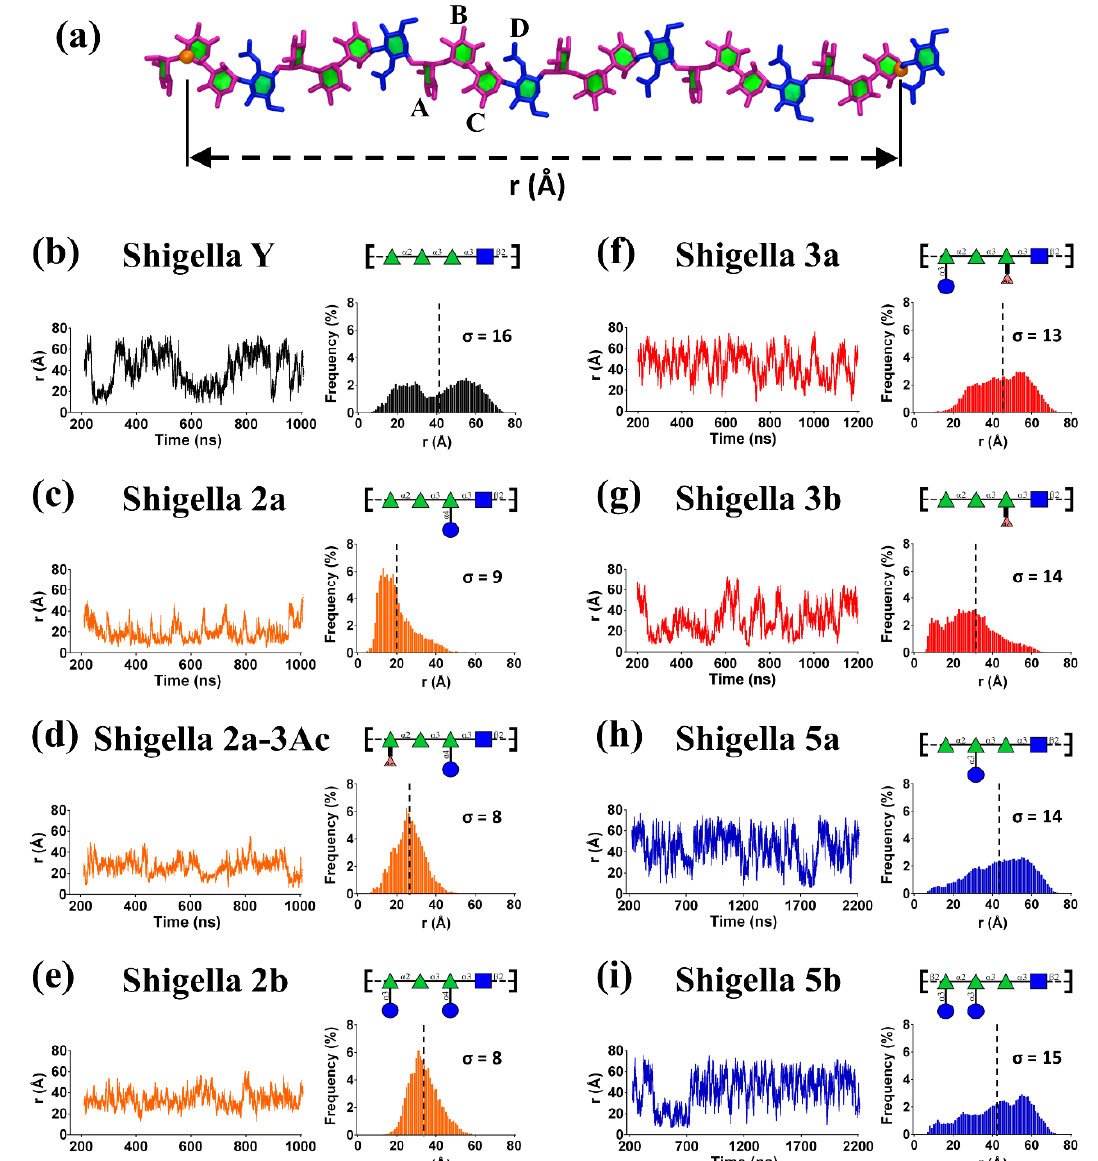
Figure 2. Comparison of the r time series and corresponding histograms for 6 RU simulations of the modeled S. flexneri O-Ags. ( a ) A 6 RU model of the serotype Y O-Ag depicted with the end-to-end distance, r ; rhamnose is colored pink and N-acetyl-glucosamine blue. The r time series (left column for each serotype) and corresponding distribution (right column for each serotype) are shown for ( b ) Y, ( c ) 2a, ( d ) O-3 acetylated 2a, ( e ) 2b, ( f ) 3a, ( g ) 3b, ( h ) 5a, and ( i ) 5b. The mean for each histogram distribution is depicted with a dashed line and the corresponding standard deviation is